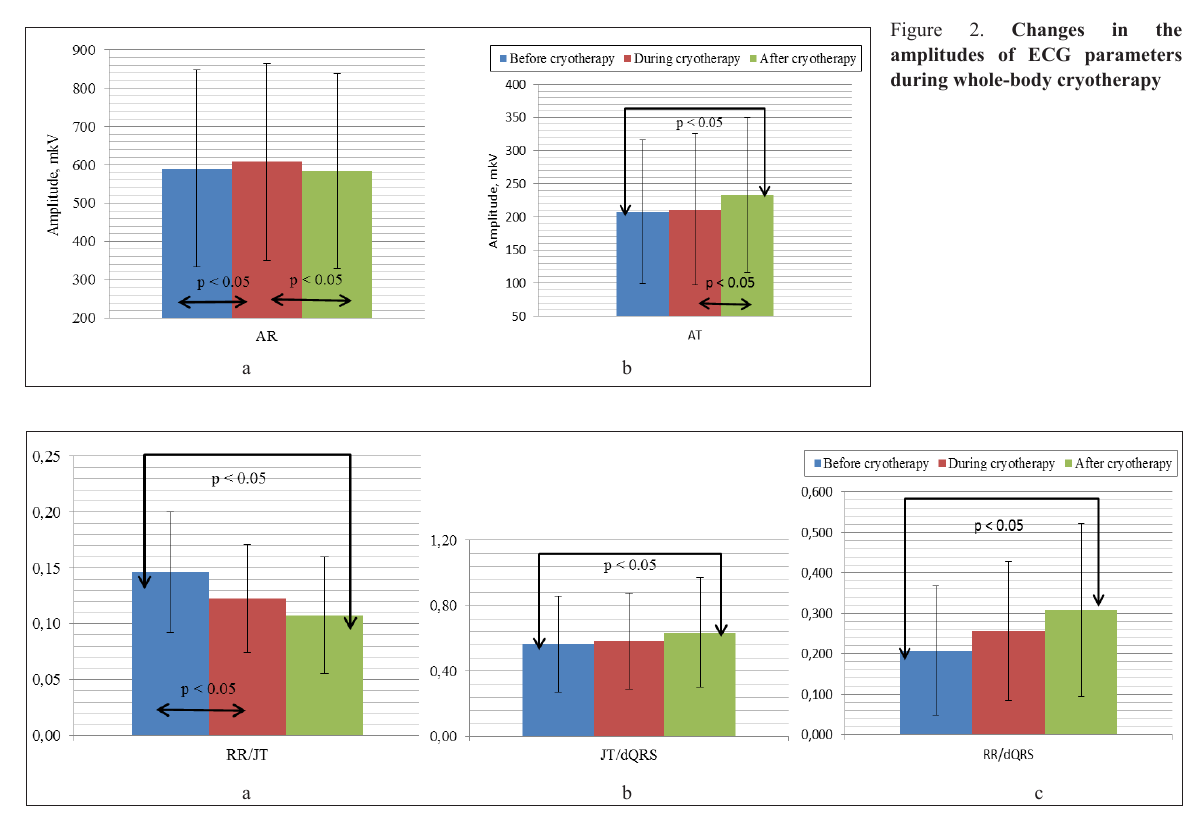
Figure 1. Changes in the duration of ECG parameters during whole body cryotherapy